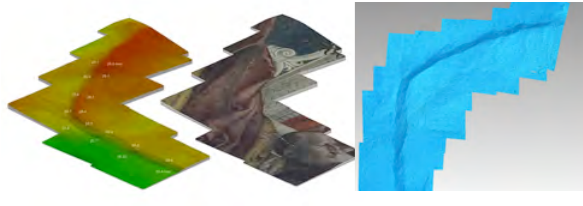
Figure 3. Range map in false colour of the north wall of the Camera degli Sposi